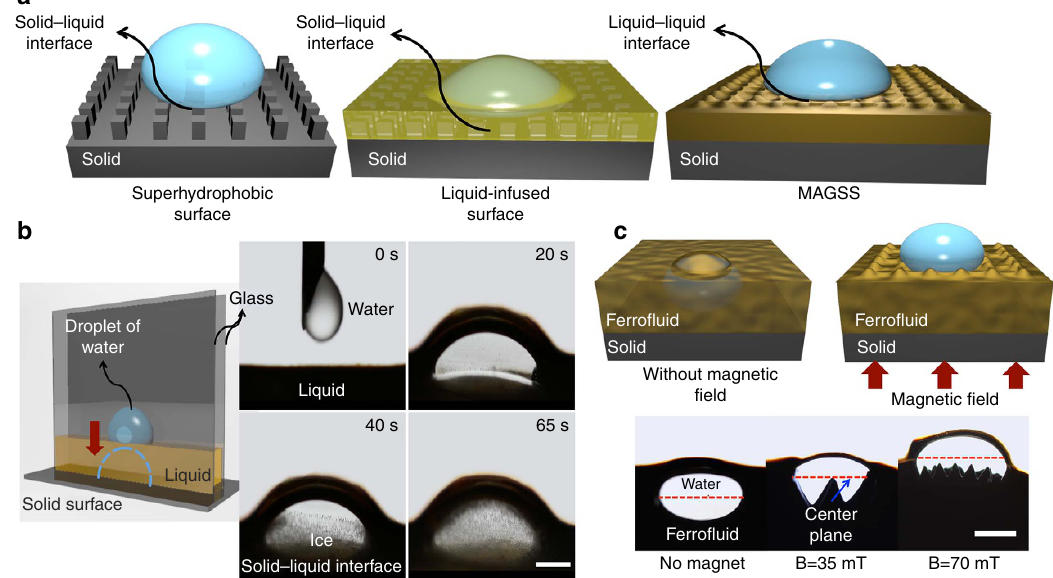
Figure 1 | Magnetic liquid–liquid interfaces in MAGSS. Physics of the formation of a liquid–liquid interface in MAGSS is discussed. ( a ) Once a water droplet touches a superhydrophobic surface or a liquid-infused surface, it forms a solid–water interface promoting heterogeneous ice nucleation on these surfaces. However, in MAGSS, the water droplet forms a magnetic liquid–water interface with lower interfacial energy than in the solid–water interfaces. That is, the energy barrier for ice nucleation is increased, and solid temperature should be lowered to satisfy thermodynamic conditions for ice nucleation. ( b ) A Hele-Shaw cell (left side) is used to elucidate penetration of water droplet in the liquid oil layer and formation of solid–water interface, leading to freezing at high temperature, (the kinetics of ice formation is shown on the right side). ( c ) Although the difference in the interfacial energy exists in MAGSS, the induced volumetric force dominates the interfacial force and leads to formation of a magnetic liquid–water interface. In a Hele-Shaw configuration, displacement of the water droplet to the surface in the presence of magnetic field is shown. That is, the volumetric force by the magnetic field does not allow formation of a solid–water interface. Low energy of magnetic liquid–liquid interface increases the energy barrier for ice formation. We emphasize that the amplitude of the induced surface waves at the water-ferrofluid interface can be decreased by low surface tension ferrofluids or higher magnetic fields. (Supplementary Movie